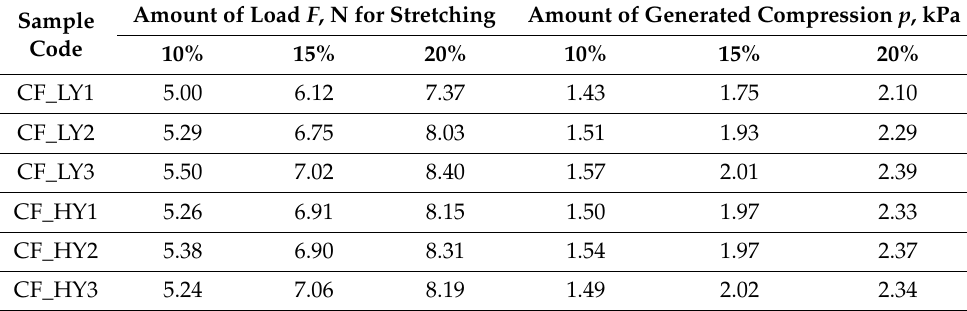
Table 5. Tensile force and corresponding compression at the different stretch levels.